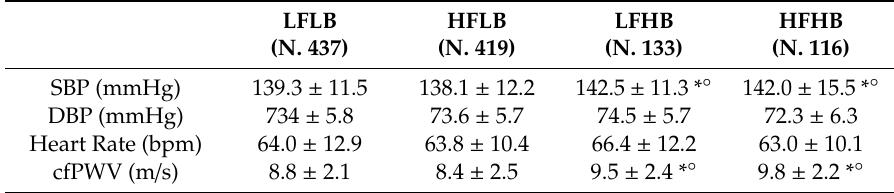
Table 3. Haemodynamic characteristics of the studied population subgroups (values reported as mean ± standard deviation).